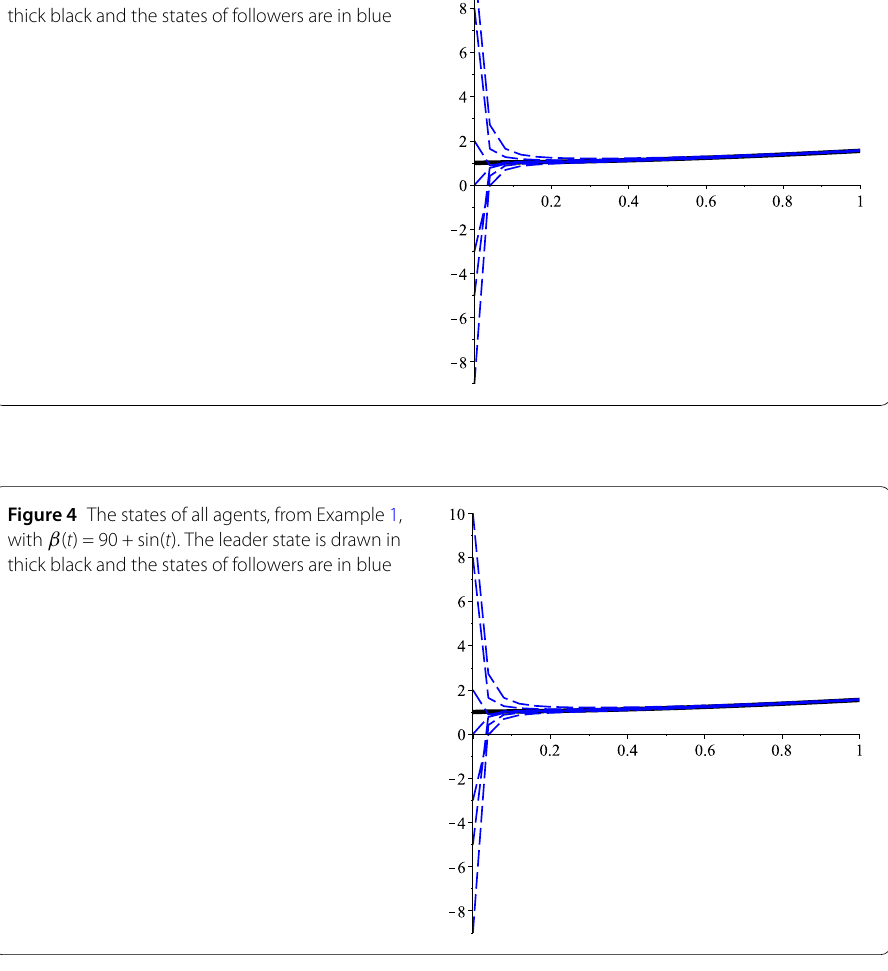
Figure 3 The states of all agents, from Example 1, with f ( t , z ) = sin( t )sin( z ). The leader state is drawn in thick black and the states of followers are in blue